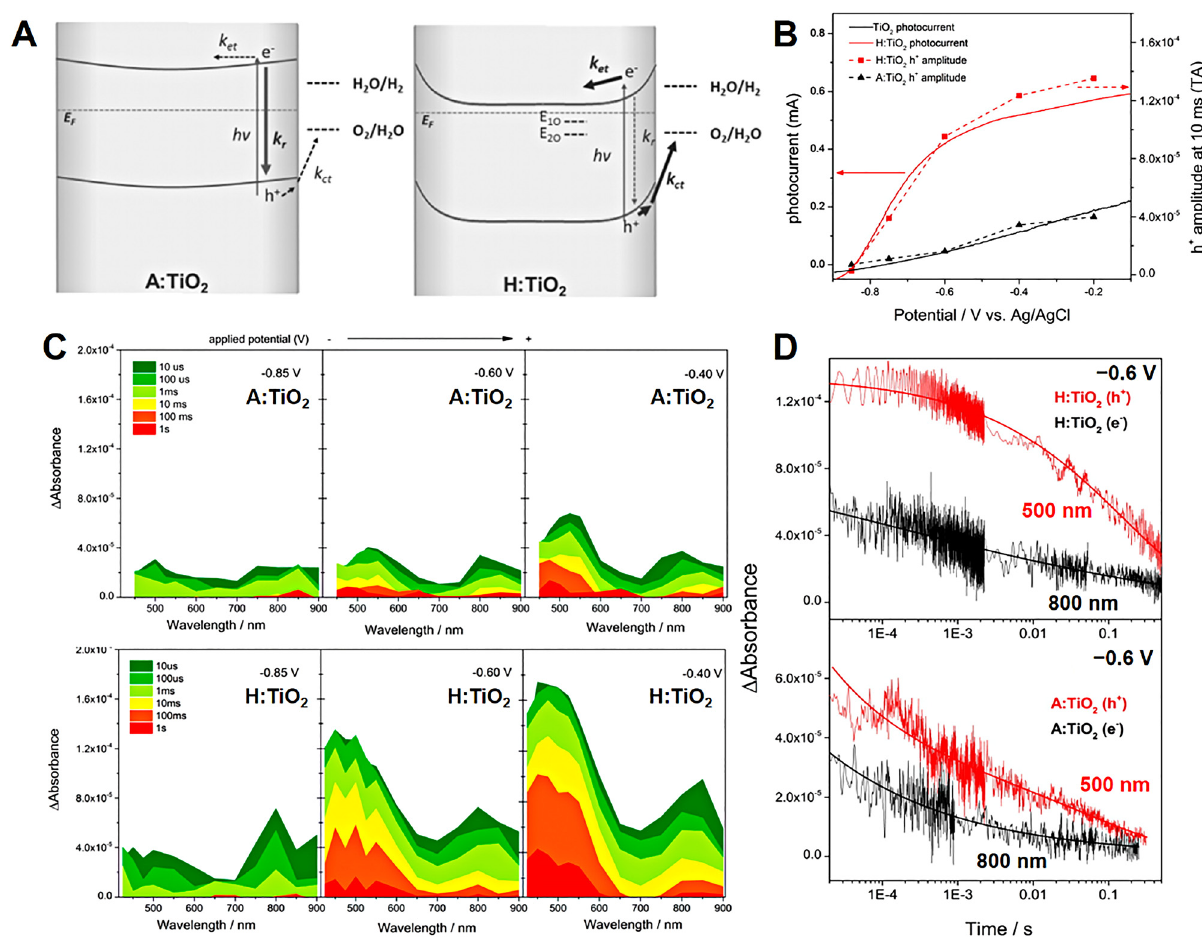
Figure3: (A)ProposedchargedynamicsmechanismofA:TiO 2 andH:TiO 2 atananodicbiasafterUVexcitation. k ct , k r and k et respectivelystand for the rate constants of the charge transfer into the solution, the charge recombination, and the electron transfer. E 1O and E 2O respectively denote the two states of V O at 0.75 and 1.2 eV below the conduction band edge. (B) Linear-sweep voltammograms and in situ transient absorption (TA) amplitude change at 500 nm and 10 ms after UV excitation ( λ = 355 nm, 70 μ J cm − 2 ) for A:TiO 2 and H:TiO 2 in 1 M NaOH under various applied biases. (C) TA pro fi les of A:TiO 2 and H:TiO 2 at different applied biases. (D) TA decay pro fi les of photoholes (500 nm) and trapped photoelectrons (800 nm) for H:TiO 2 and A:TiO 2 at − 0.6 V. Reprinted with permission from a study by Pesci et al. [39]. Copyright 2013 American Chemical